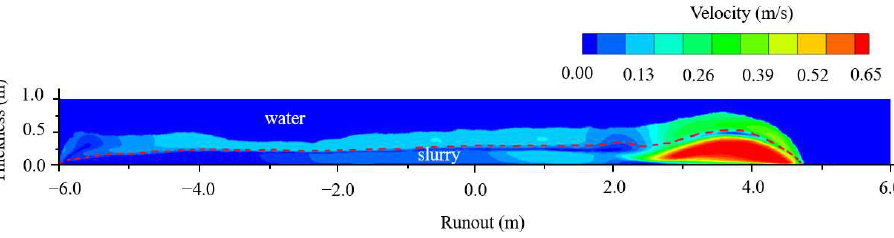
Figure 6. Velocity contour of the slurry at 6 s.